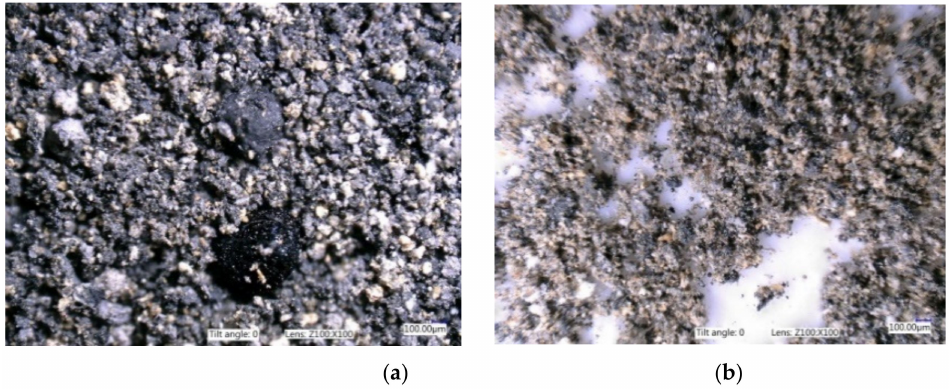
Figure 1. Images of BCA magnification × 1.00: ( a ) ash BCA1 and ( b ) ash BCA2.